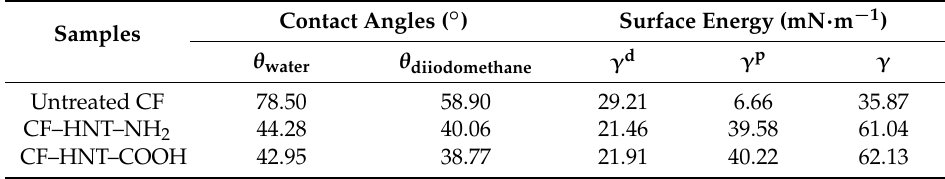
Table 1. Contact angles and surface energy of different